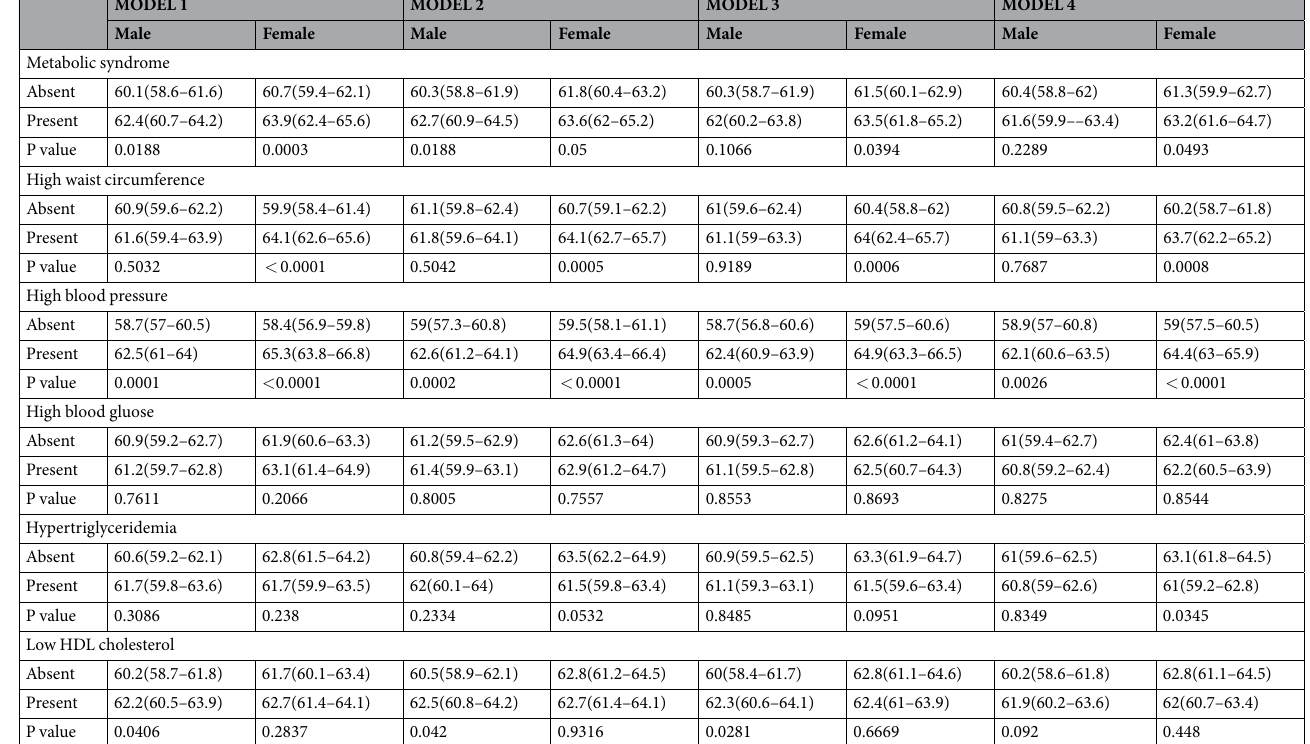
Table 2. Comparison of parathyroid hormone levels between groups according to presence or absence of metabolic syndrome or its components. MODEL 1 non–adjusted. MODEL 2 age, sex. MODEL 3 age, sex, smoke, exercise, education levels, income status, calcium intake. MODEL 4 age, sex, smoke, exercise, education levels, income status, calcium intake, vitamin